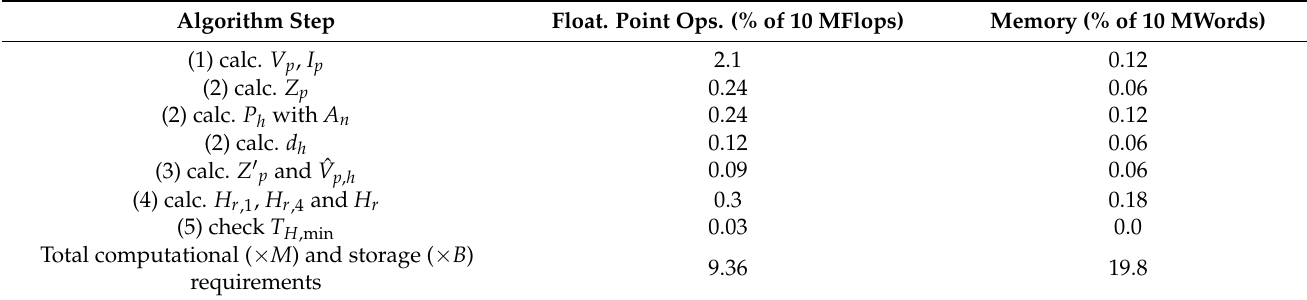
Table 2. Summary of estimated computational and memory budget ( f s = 50 kSa/s, N = 3000). Algorithm steps are numbered as in the flowchart of Figure